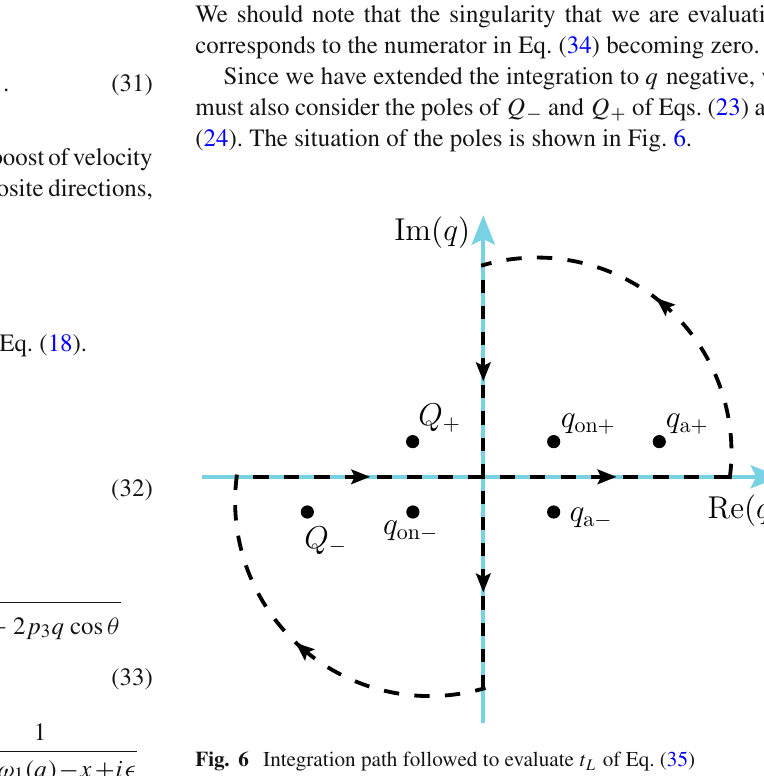
Fig. 6 Integration path followed to evaluate t L of Eq.